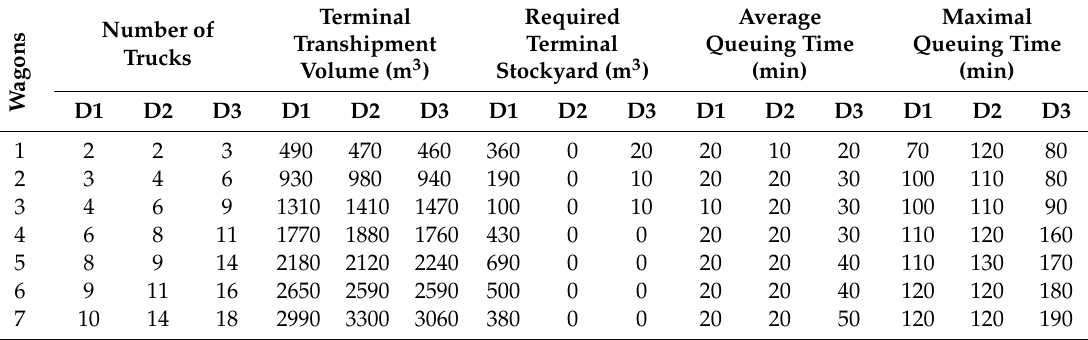
Table 10. Best simulation results for strategy BEST FIT (at least 90% terminal transhipment volume) for two train